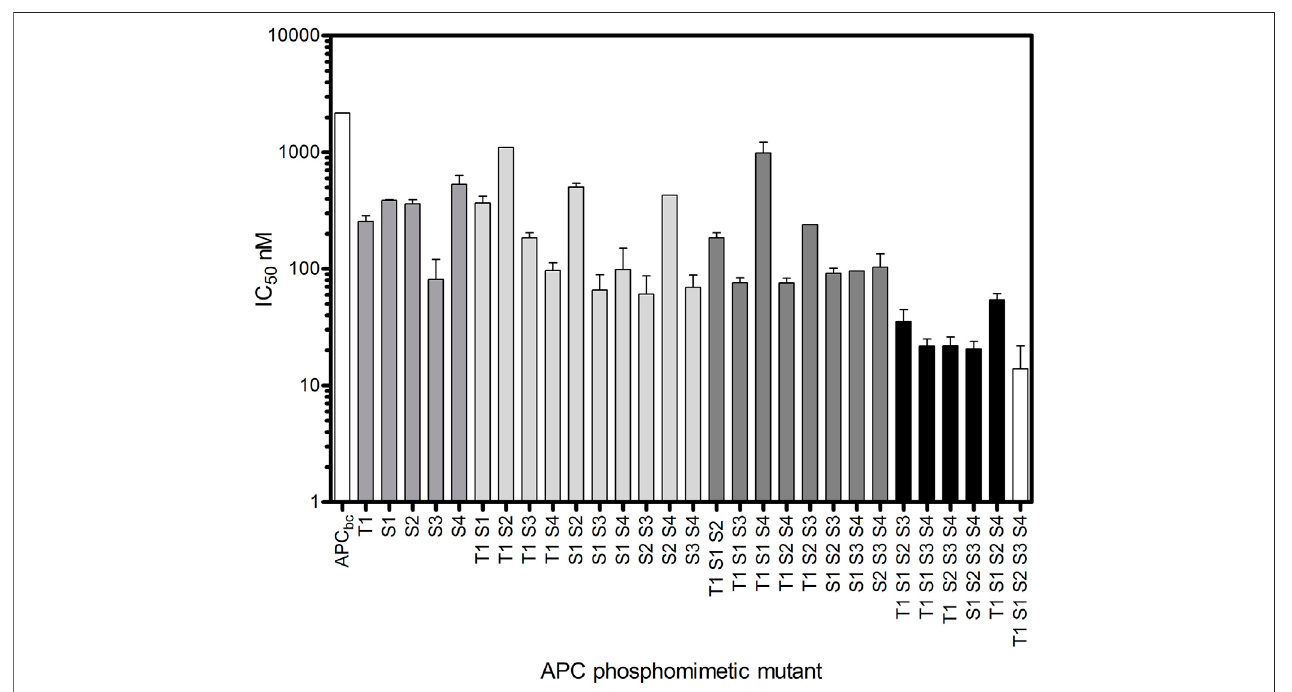
FIGURE 3 | Increasing af fi nity for β -catenin of APC bc constructs with increasing number of phosphomimetic substitutions. Glutamate substitutions were made at phosphorylation sites T1487E (T1), S1504E (S1), S1505E (S2), S1507E (S3), S1510E (S4). The IC 50 s of these phosphomimetic APC bc variants was measured by fl uorescence competition assay using APC bc labelled with Alexa488 at Cys 1501. The data are shown as the mean ± SEM of three replicates.